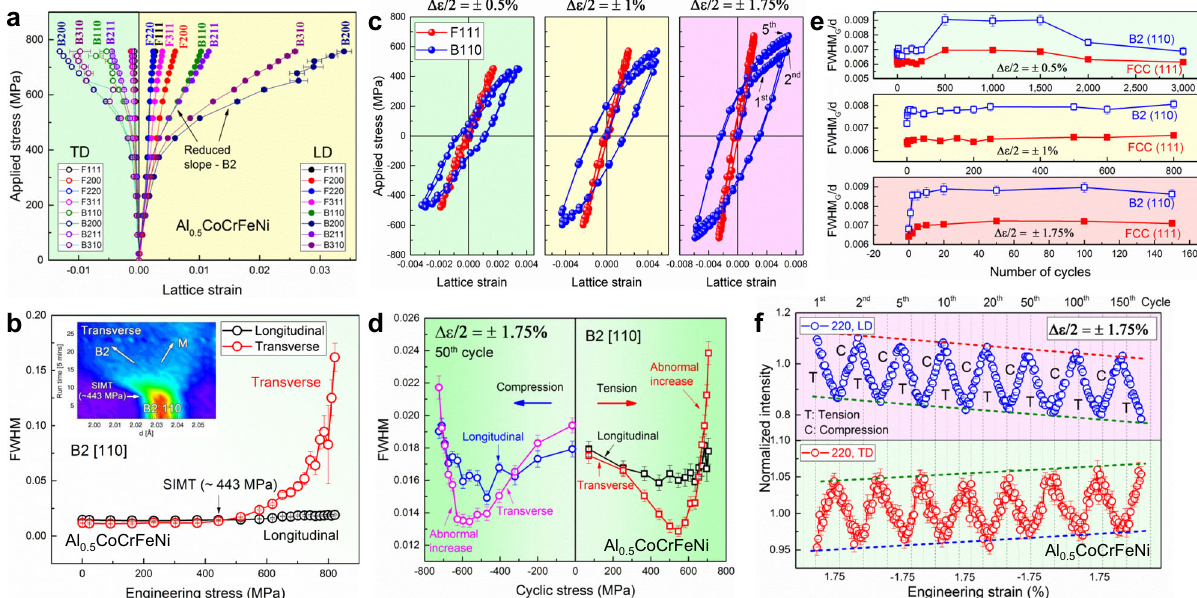
Fig. 3 Real-time in situ neutron-diffraction results. a Lattice strain as a function of applied stress during the uniaxial tension. b The evolution of FWHM as a function of stress along the transverse direction during tension [The inset is a two-dimensional (2D) contour map showing the evolution of the B2-{110} d-spacing], indicating the presence of martensitic transformation. c Lattice-strain evolutions of the FCC-{111} and B2-{110} at selected fi rst, second, and fi fth cycles along the loading direction. d The relationship of the B2-[110] FWHM versus applied stress along longitudinal and transverse directions at the 50th cycle with the strain amplitude of ±1.75%. e The evolution of FWHM G /d versus the number of cycles at the strain amplitudes of ±0.5%, ±1%, and ±1.75%. f In situ neutron diffraction peak-intensity evolution at different fatigue cycles along longitudinal and transverse directions at the strain amplitude of ±1.75%. The error bars in all the fi gures are obtained from the uncertainties of the single-peak fi tting on hkl diffraction